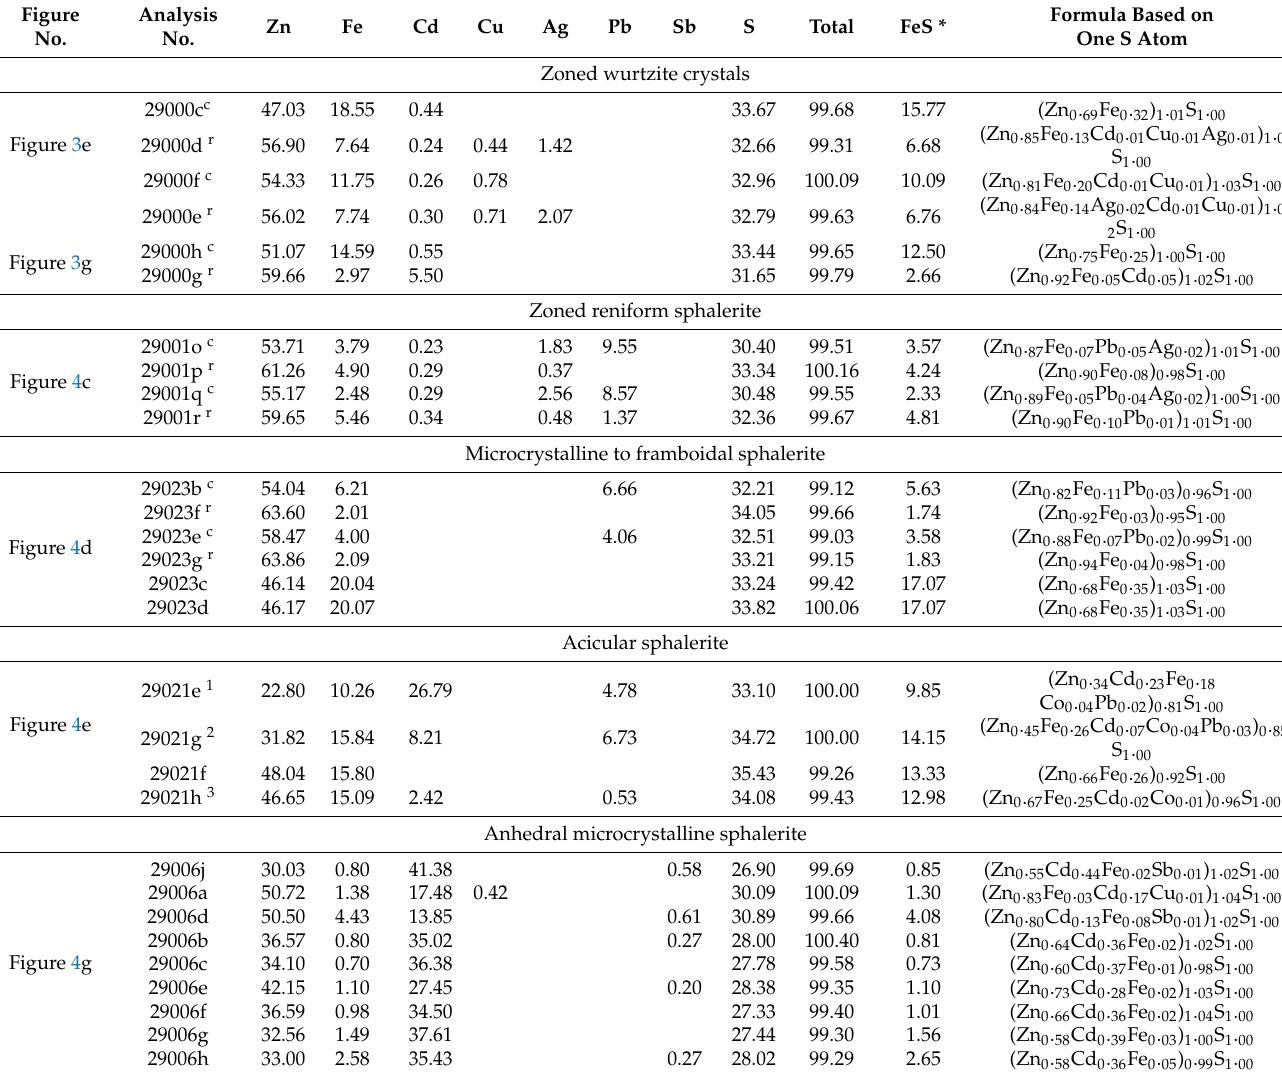
Table 2. Selected chemical composition of Zn sulfides from the Irinovskoe HSF, wt%. Figure Analysis No. No.